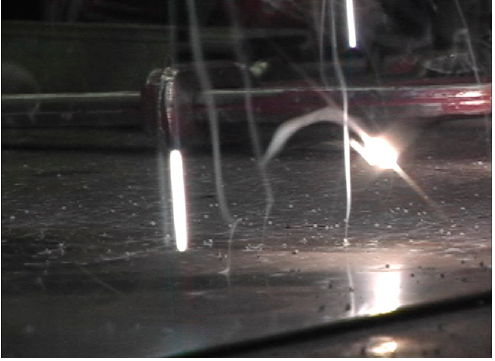
Figure 17. Un-ignited aluminum particles sticking on impact with SS plate.